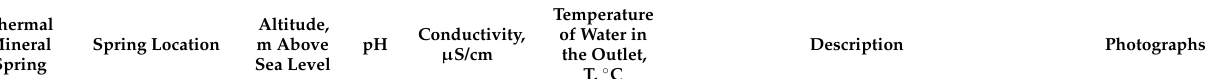
the bottom. Description Photographs